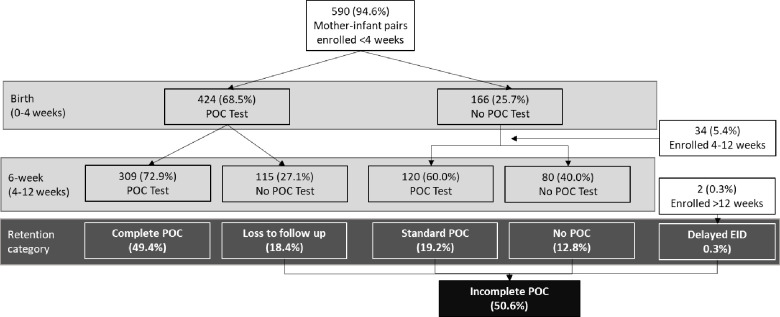
Repeat POC testing at birth and 6-weeks.